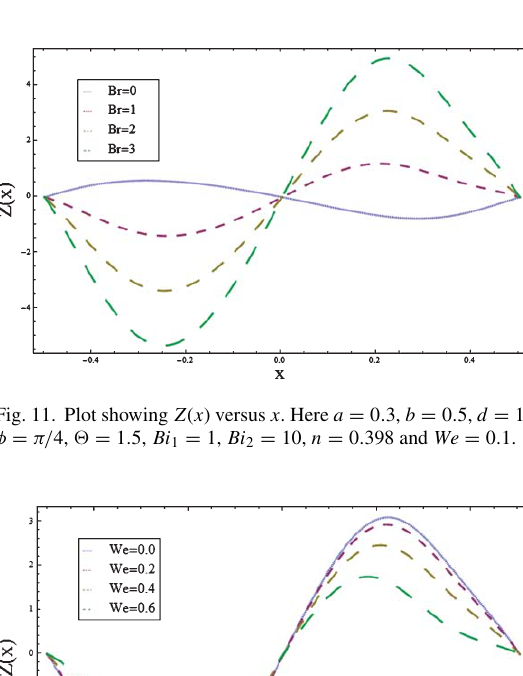
Fig. 8. Plot showing θ versus y . Here a = 0 . 3, b = 0 . 5, d = 1, φ = π/ 4, (cid:14) = 1 . 5, n = 0 . 398, Bi = 10, Br = 1, x = 0 . 2and We = 0 . 3. 1